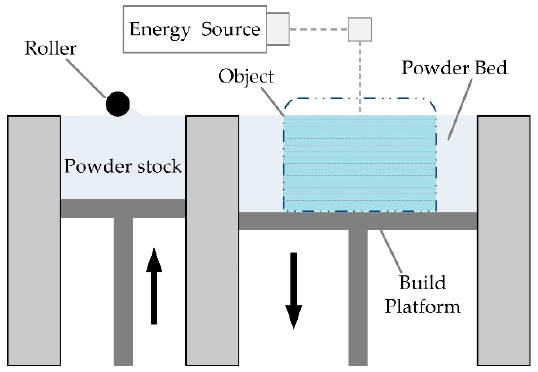
Figure 2. Schematic of Powder Bed Fusion process.